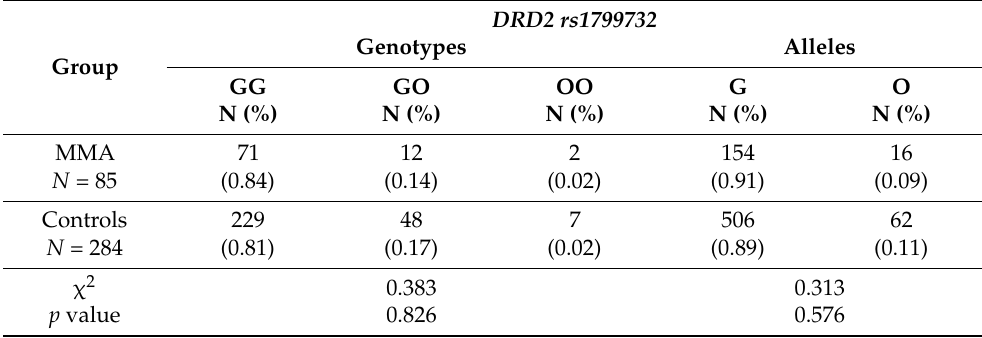
Table 3. Frequencies of genotypes and alleles of the DRD2 rs1799732 polymorphism in MMA subjects and controls.